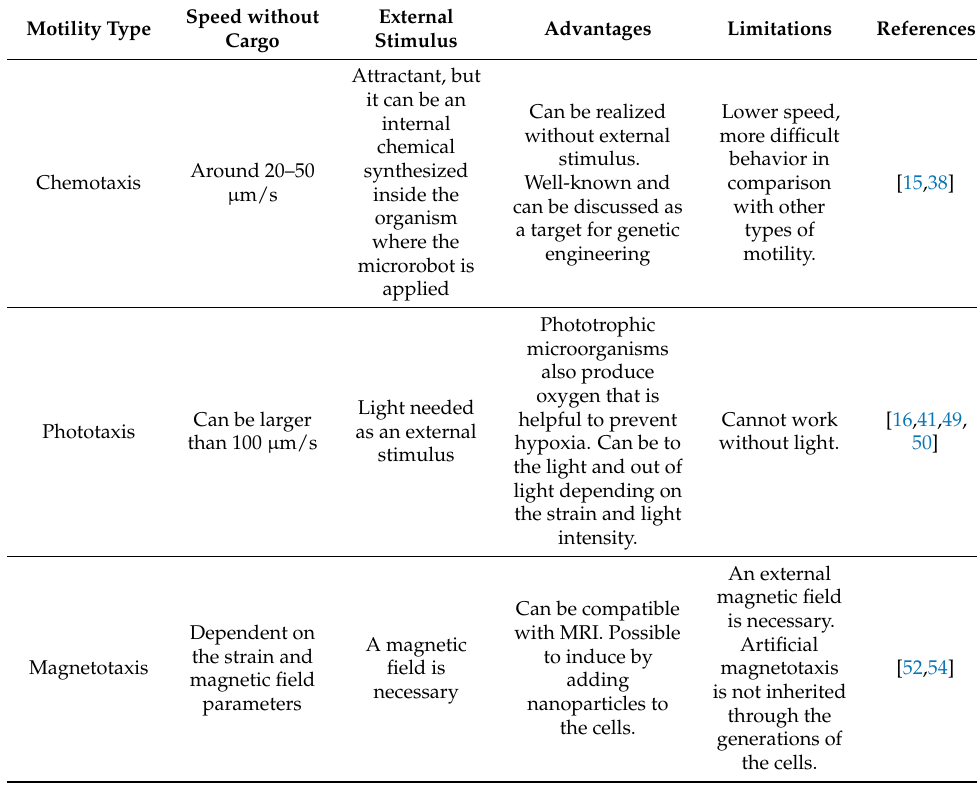
Table 1. Advantages and limitations of the microrobot’s motility